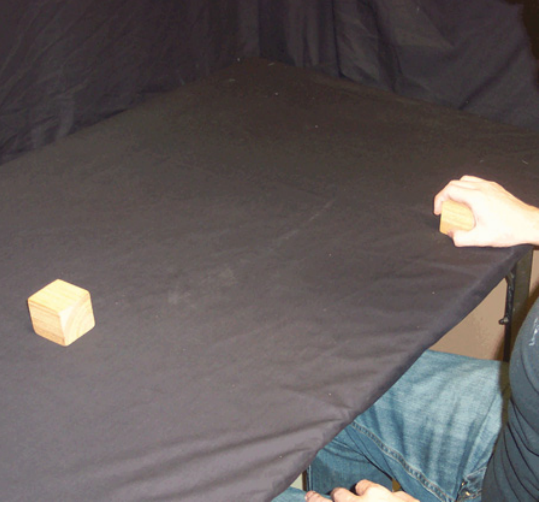
Fig 6. Reach and Retrieve condition. Participant then slides the action block back and to the side along the